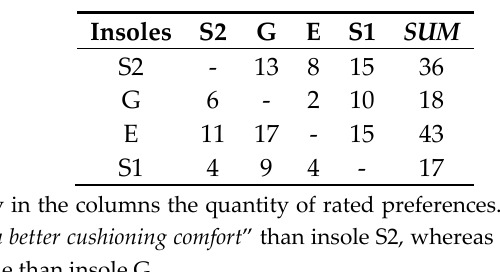
Table 2. Pairwise comparison test (PWCT) matrix of all testers (n = 19) answering question Q2.